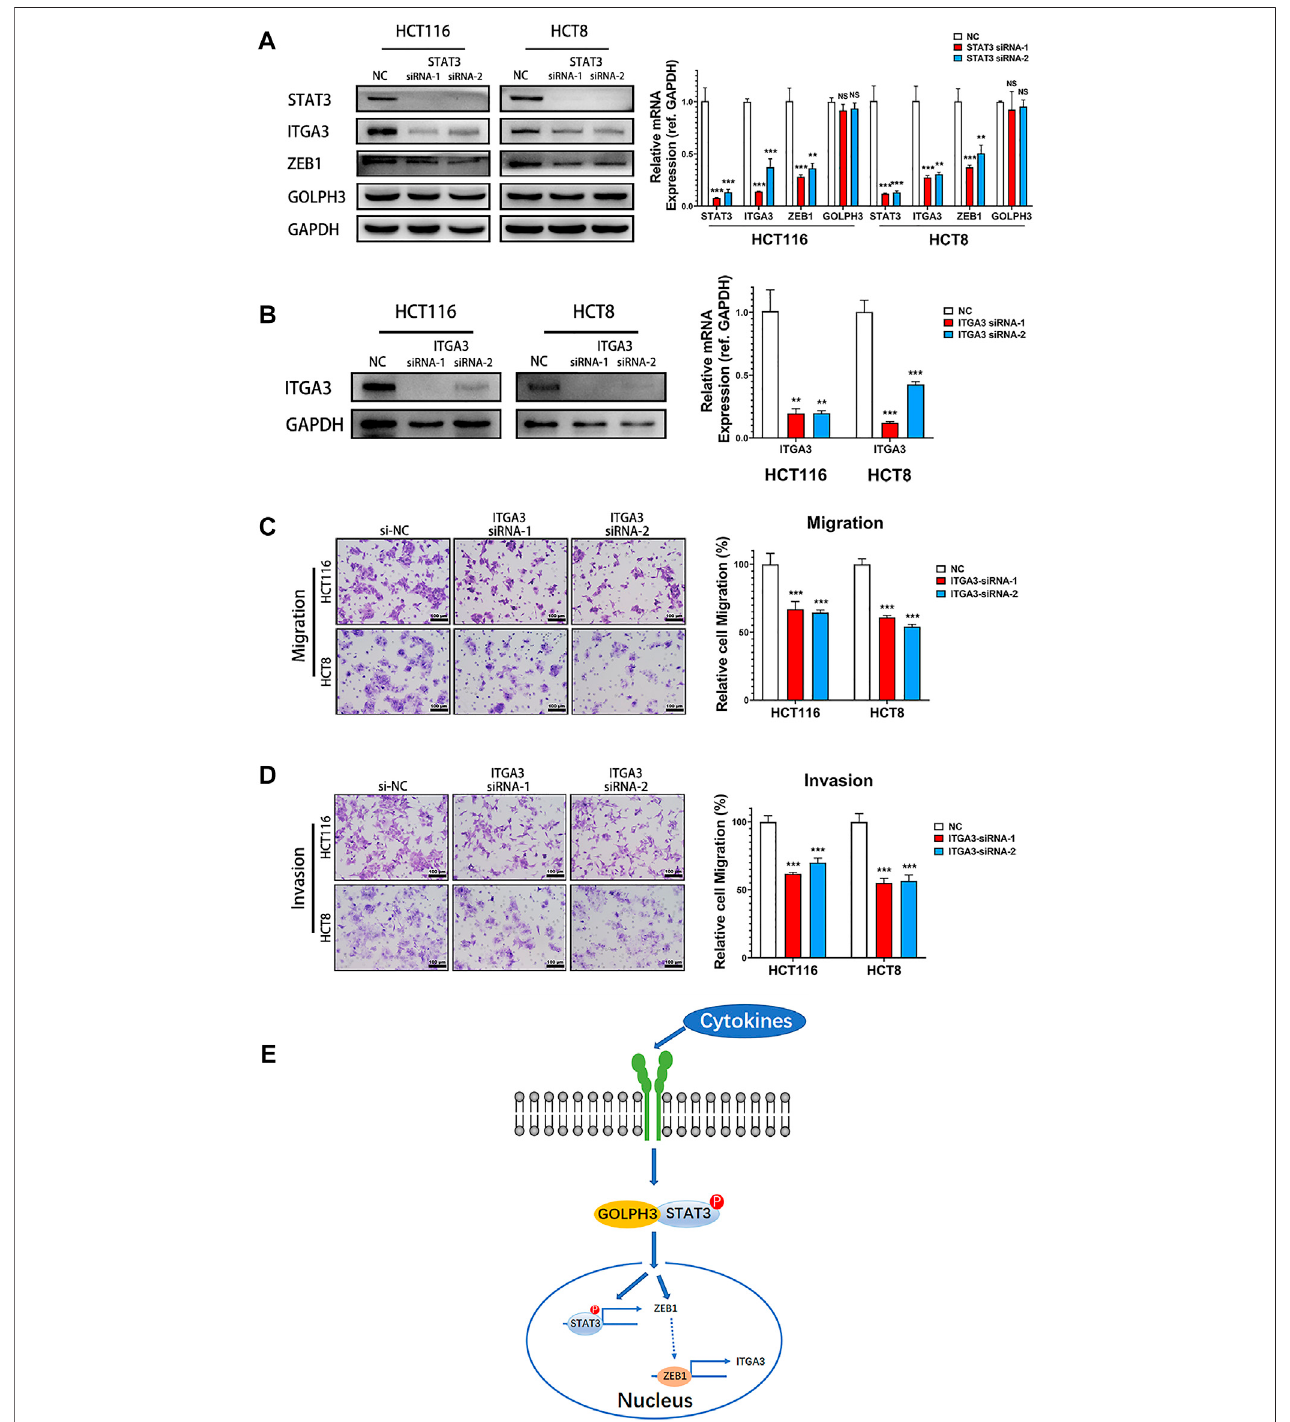
FIGURE5| SilencingofSTAT3down-regulatedtheexpressionofintegrin α 3andknockdownofintegrin α 3inhibitsmetastaticphenotypesofcoloncancercells. (A) Expression of ZEB1, integrin α 3, and GOLPH3 of control and STAT3 siRNA transfected cells were assessed using western blotting and qRT-PCR. (B) Integrin α 3 expression incontrolandintegrin α 3siRNA transfected cellswereassessed usingwesternblottingand qRT-PCR. (C,D) Theeffect ofintegrin α 3knockdown inHCT116 andHCT8cellsmigrationorinvasionwereexaminedbytranswellassay.ThenumberofmigratoryorinvasivecellswerecountedandnormalizedtotheNCgroupin fi ve randomly selected fi elds. Representative micrographs are also shown (×200 magni fi cation). (E) Working model. GOLPH3 interacts with p-STAT3 and regulates ZEB1 and integrin α 3 to promote the metastasis of CRC. Scale bar, 100 µm. For (A,B) , results were reproduced in three independent experiments, and representative immunoblots are shown. ** p < 0.01, *** p < 0.001.